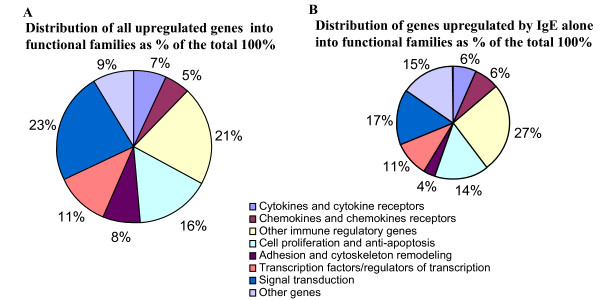
Pie chart showing the percentage distribution of the upregulated genes. A. Percentage distribution of the total amount of genes upregulated. All the genes, observed to be upregulated at least 2-fold at any given time point, were distributed, according to their biological function described in table 1. B. Percentage distribution of genes upregulated by IgE alone. Distribution, according to biological function, of the genes observed to be upregulated during IgE sensitization (IgE alone).